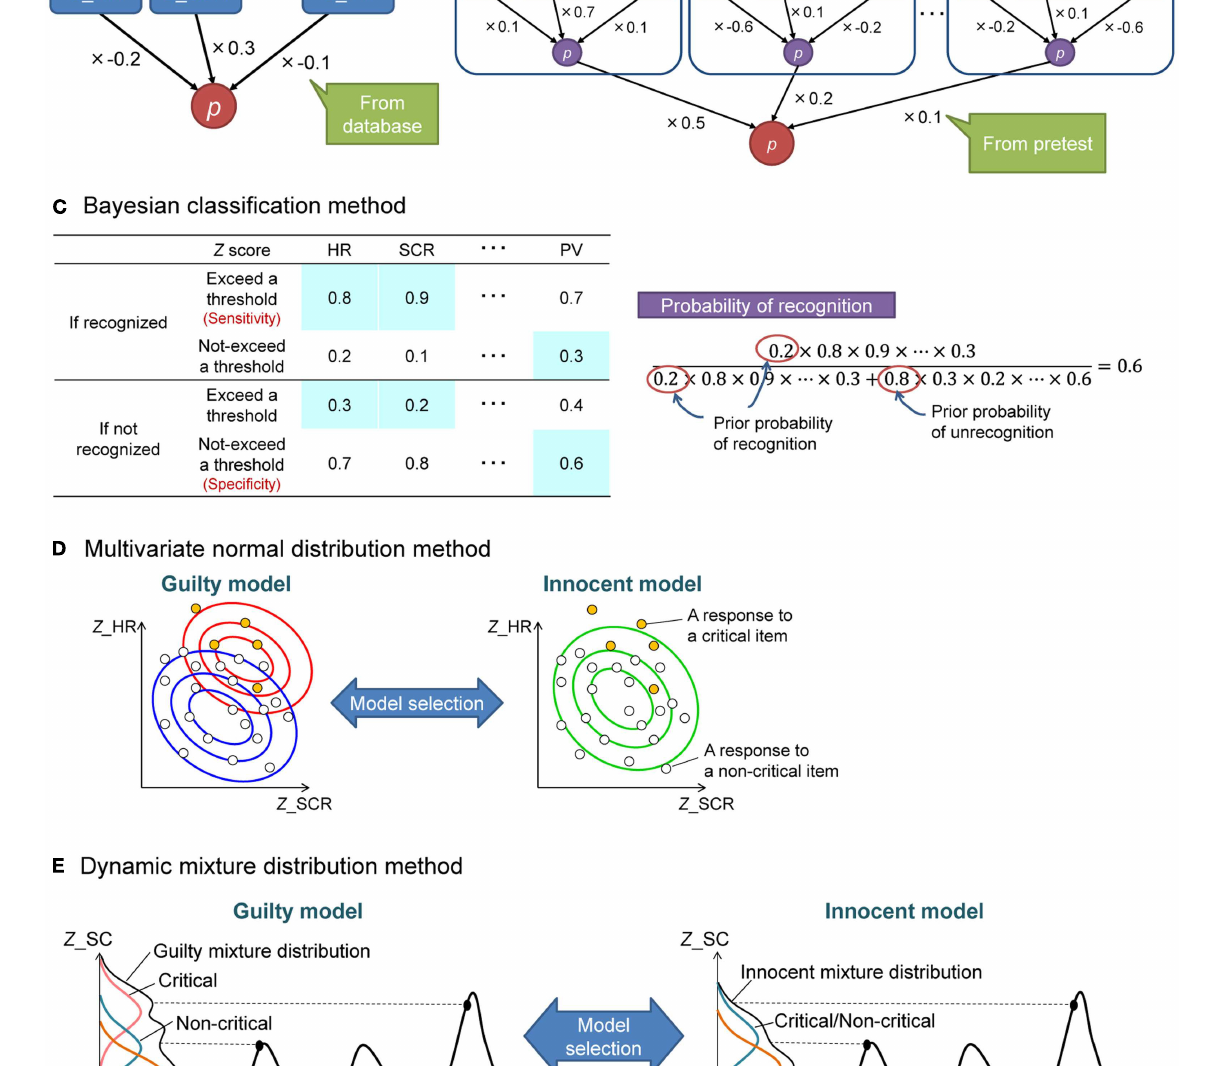
the recognition condition. Here is the case that a participant’s heart rate change and skin conductance response exceeded the threshold, while his/her pulse volume did not exceed the threshold. (D) In the multivariate normal distribution method, a guilty model (two-distribution model) and an innocent model (one-distribution model) are applied to the obtained responses in a CIT (each small circle represents a response to a critical (yellow) or a non-critical (white) item).The better fitted model will be selected. (E) The dynamic mixture distribution method uses time series and is an extended version of the multivariate normal distribution method. In this method, a guilty model (representing time series with a mixture of three distributions) and an innocent model (representing time series with a mixture of two distributions) are applied to the obtained time series in a CIT.The model that fits the time series best is